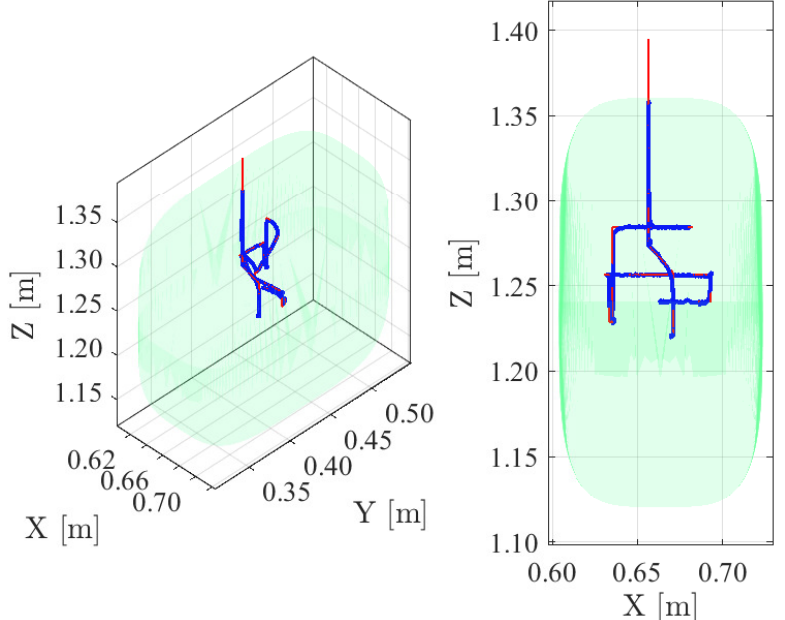
Figure 19. The 3D trajectory performance for the fourth experiment, showing the simultaneous teleoperation of both robots (see the video at https://media.upv.es/player/?id=29330720-8a8b-11ec- 97cd-ab744f931636 (accessed on 26 April 2022) [84]): 3D allowed region in green; trajectory followed by the user reference in thin red line; and trajectory followed by the WR end-effector in thick blue